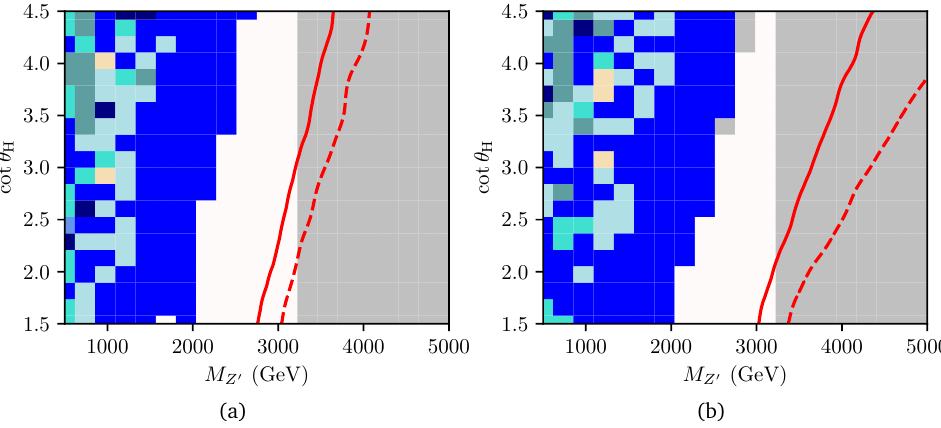
Figure 1: Sensitivity to the leptophobic TC model, in the Z ′ mass (GeV) versus the cot θ plane. The coloured blocks indicate the most sensitive final state (see legend H below). The 95% CL (solid red) and 68% CL exclusion (dashed red) contours are superimposed, considering the data as background. (a) NLO t ¯ t signal calculated using POWHEG , (b) signal calculated using Herwig (inclusive